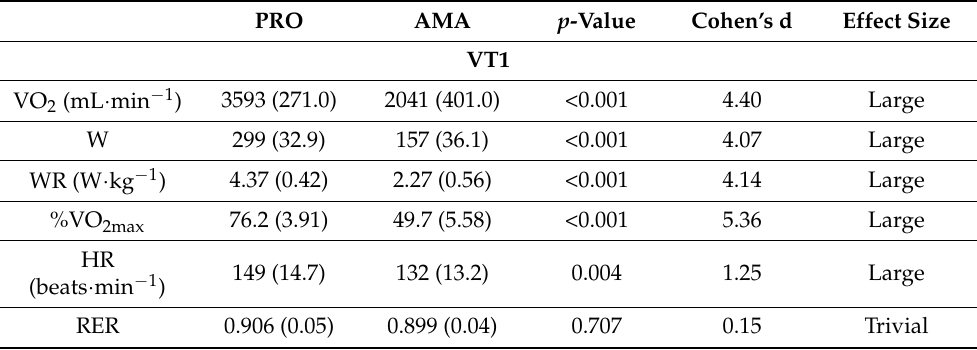
Table 3. Metabolic and performance variables of professional and amateur